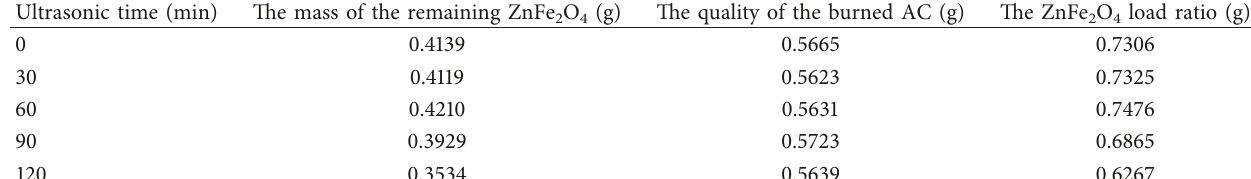
Table 1: Influence of ultrasonic time on the ZnFe